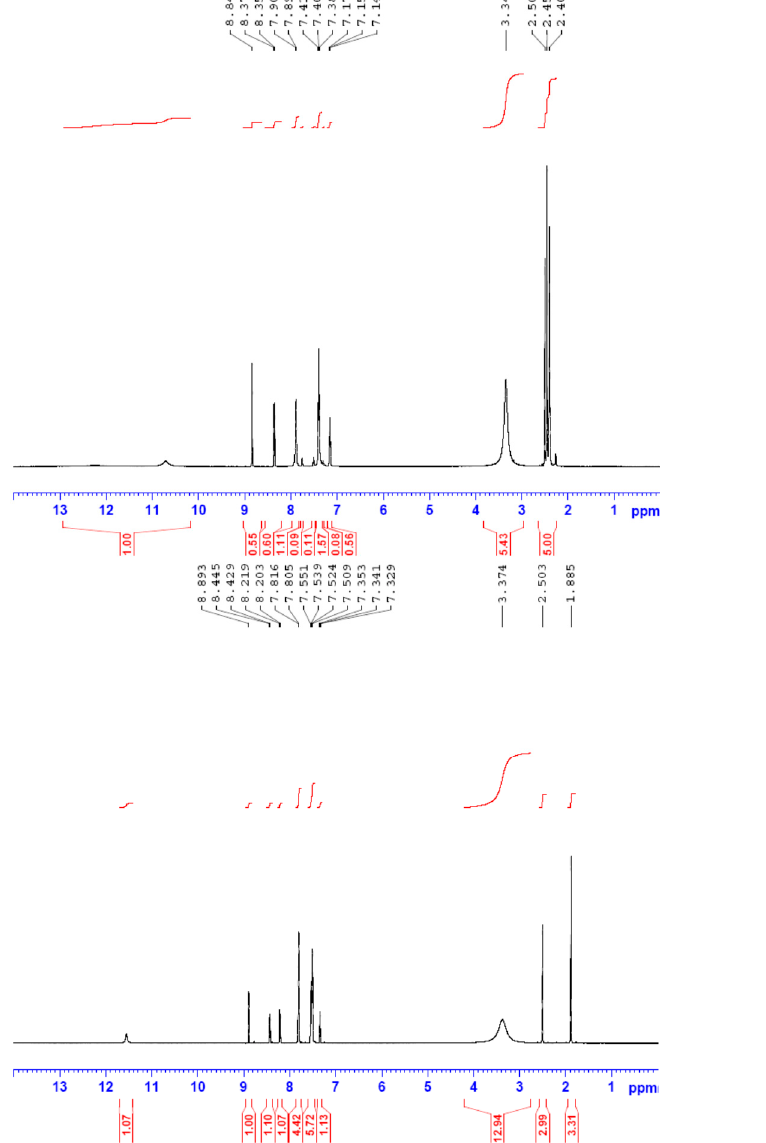
Figure 4. ( I ) 1 H NMR spectrum of Ampp-Dh; and ( II ) 1 H NMR spectrum of Bmpp-Dh.